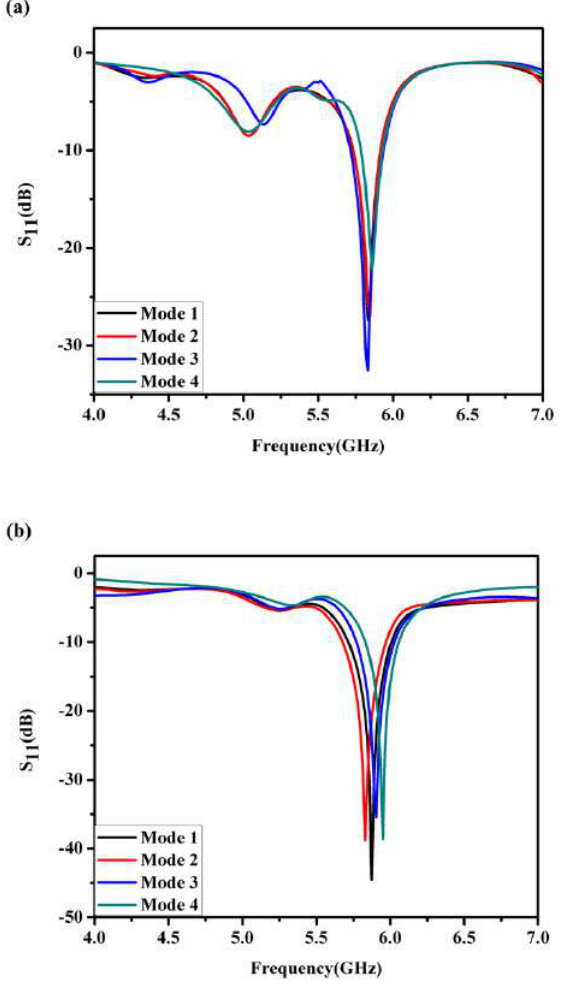
FIGURE 7. (a) Simulated, and (b) Measured S 11 plot for different modes of the proposed PRPA.